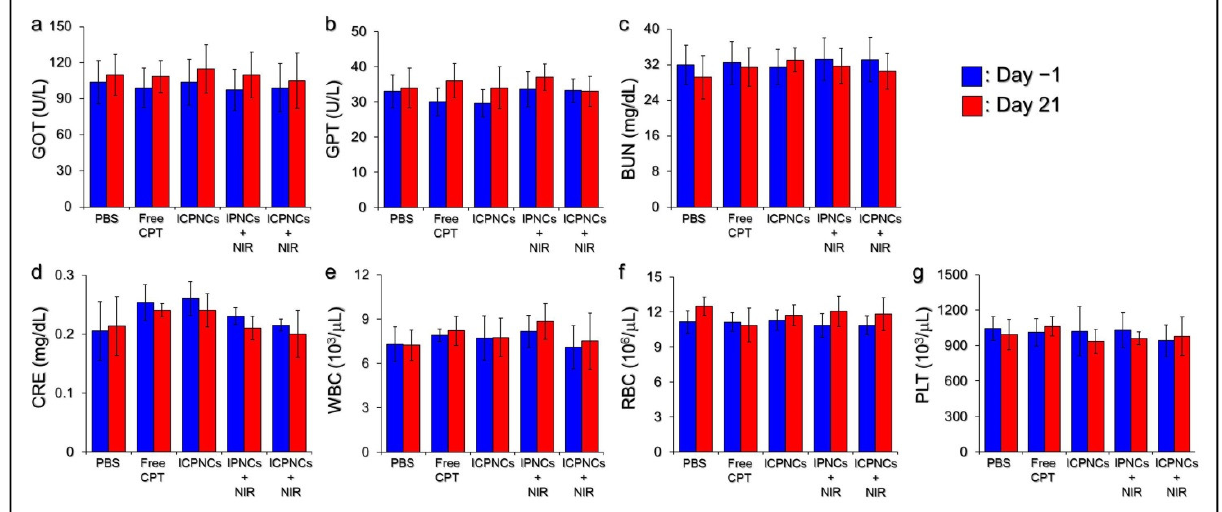
Figure 8. Blood biochemical analyses of the experimental mice. The expression levels of liver ( a , b ) and kidney ( c , d ) functional markers as well as the numbers of white blood cells ( e ), red blood cells ( f ), and platelets ( g ) of all the experimental mice were measured 24 h before treatment (day − 1) and at the moment before sacrifice (day 21). Values are the mean ± s.d. ( n = 5).